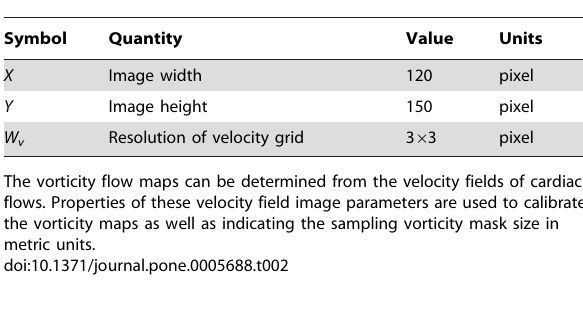
Table 1. MR imaging properties.